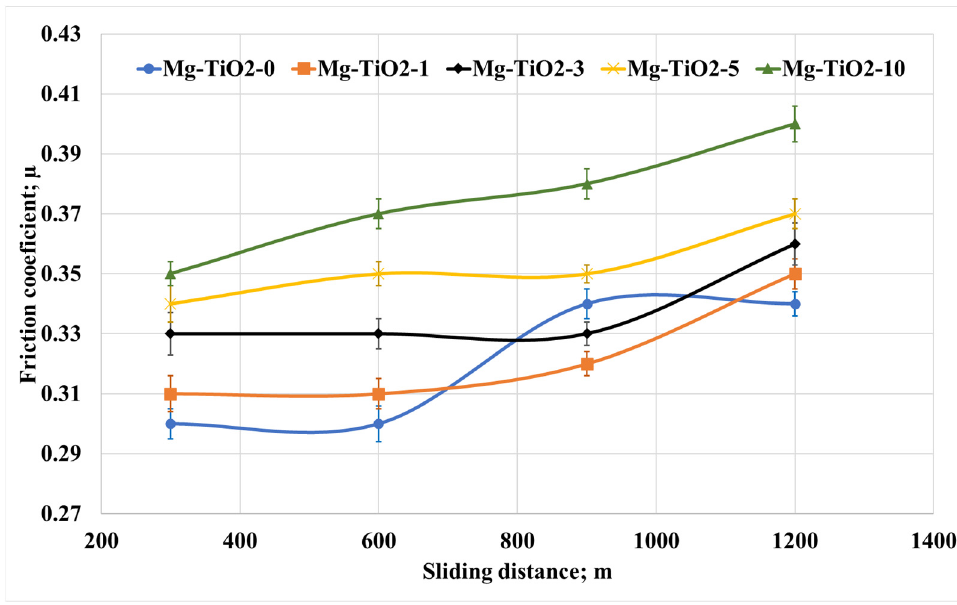
Figure 8. Friction coefficient of Mg/TiO 2 nanocomposites under different sliding distances, 30 N.